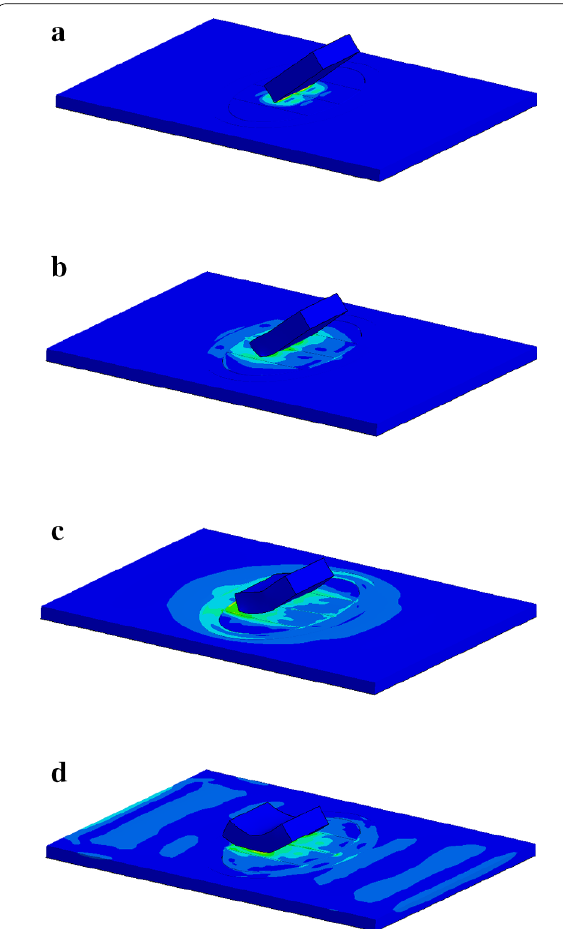
Figure 9 Numerical simulation of the access cover impact in mode B (aluminium alloy of machining) ( a ) t ms and ( d ) t 1.5 =